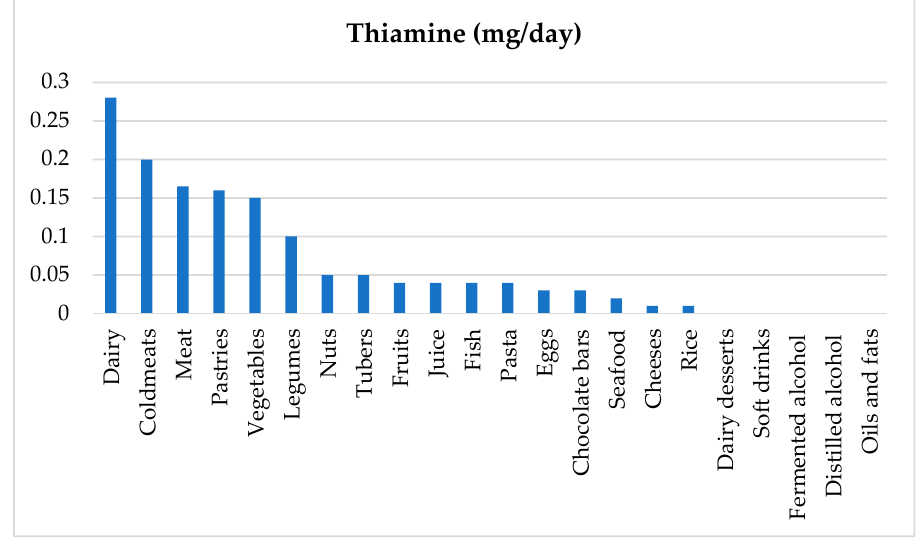
Figure 2. Nutritional sources of thiamine in the study population.